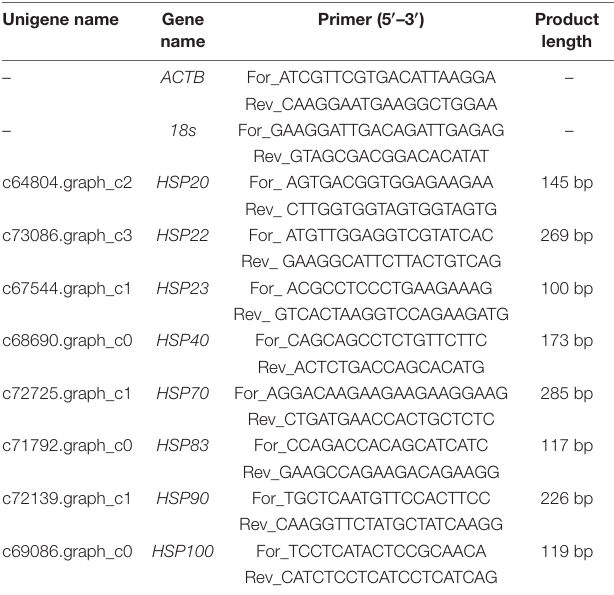
TABLE 1 | Primer sequences of reference genes and eight target genes using